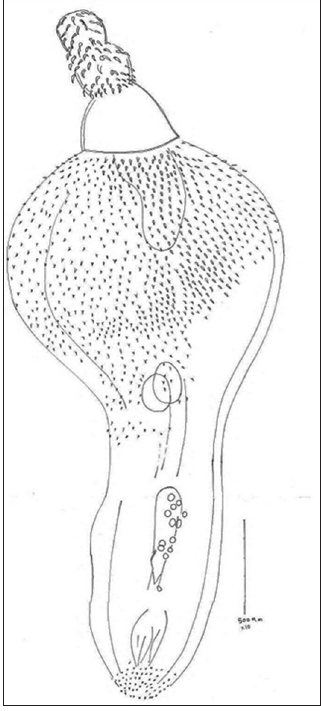
Figure-2: An adult male of Corynosoma capsicum showing anterior proboscis with longitudinal rows of hooks and the posterior proboscis with spines (scale bar: 500